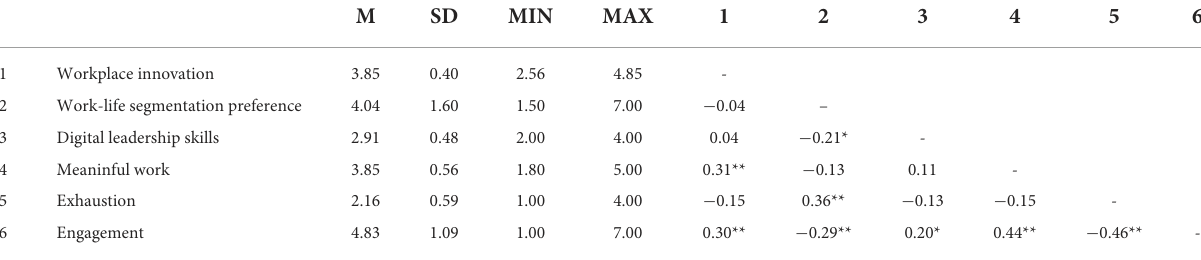
TABLE 1 Descriptive statistics and correlations.